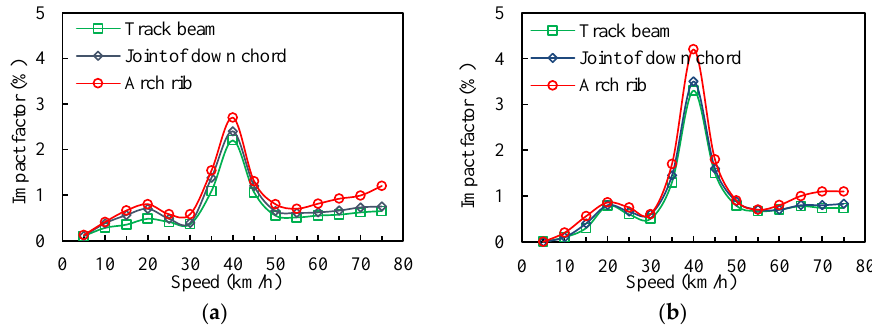
Figure 9. The impact factors of the bridge at the mid-span: ( a ) single line ; ( b ) double line.